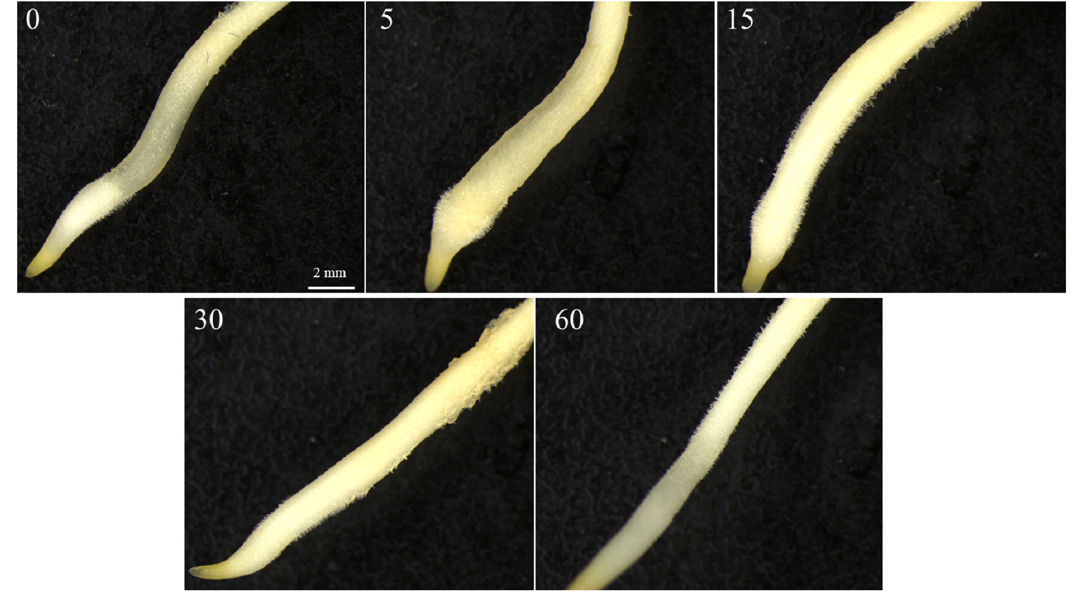
Figure 5. Detail showing the effect of 100 µmol m − 2 s − 1 red light exposure (0–60 min) of pea seeds on the development of root hairs of 3-day-old seedlings. Pictures were taking using a Leica MZ10 F modular stereo microscope with a 20x magnification.